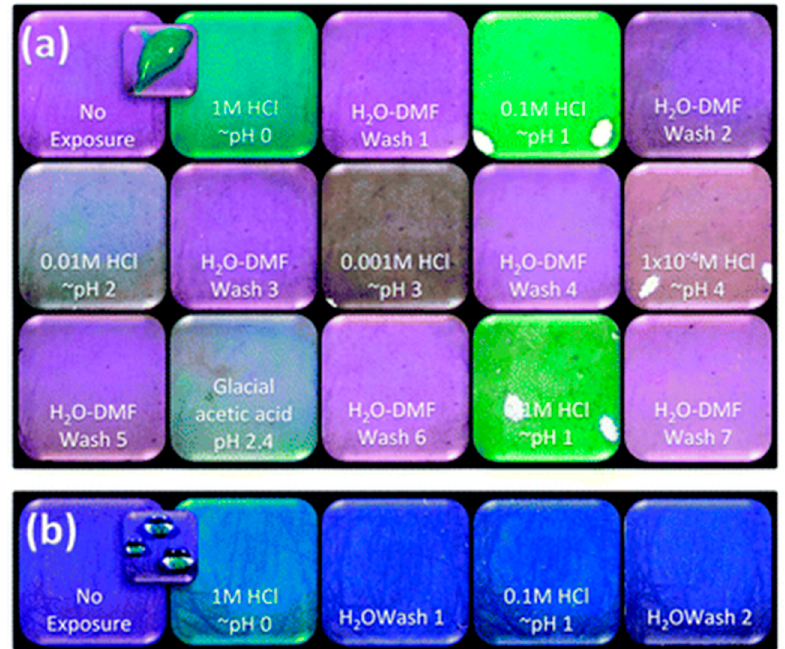
Figure 7. Photographs of the ( a ) PCN-222 and ( b ) porphyrinic linker taken under ambient light, after the exposure to various aqueous solutions and reversal washes between each exposure. Reprinted with permission from [115]. Copyright (2014) Royal Society of Chemistry.